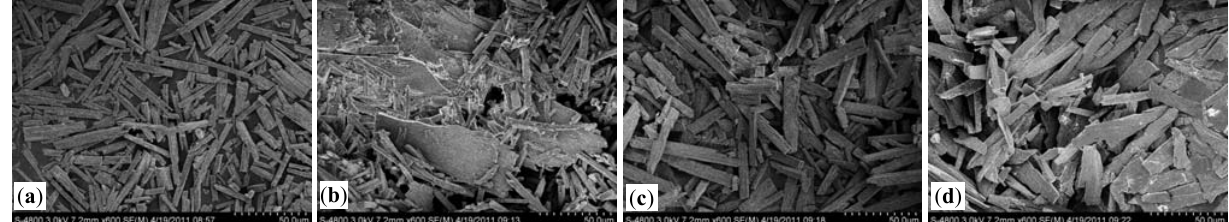
Figure 3. Morphology of struvite precipitations for four chosen chemical combinations at pH 9 and a Mg 2+ :NH 4+ -N:PO 43 − -P molar ratio of 1:1:1 as analyzed via SEM: ( a ) Na PO ·12H O + MgSO ; ( b ) NaH 3 4 2 4 ( d ) 85% H PO + MgCl ·6H 3 4 2 2